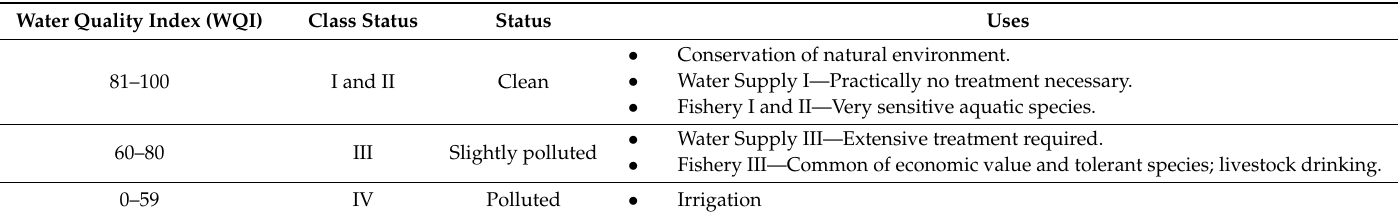
Table 7. DOE water quality classification based on